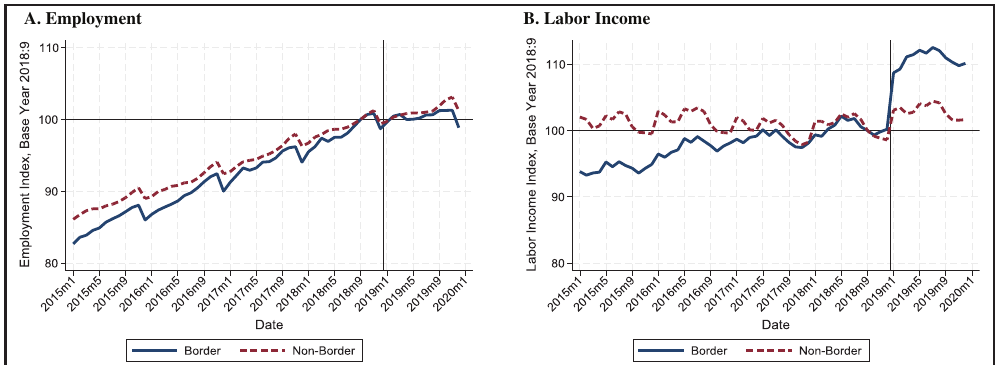
Employment and labor income between border and non-border